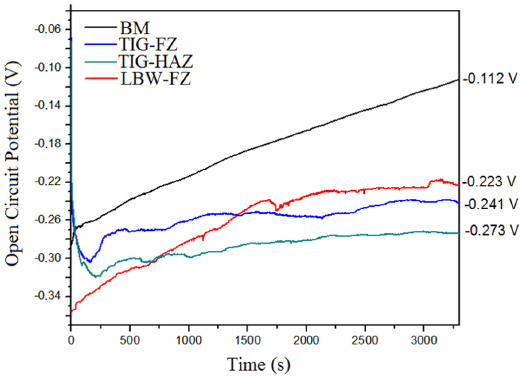
Figure 6. Open Circuit Potential (OCP) vs. saturated calomel electrode in